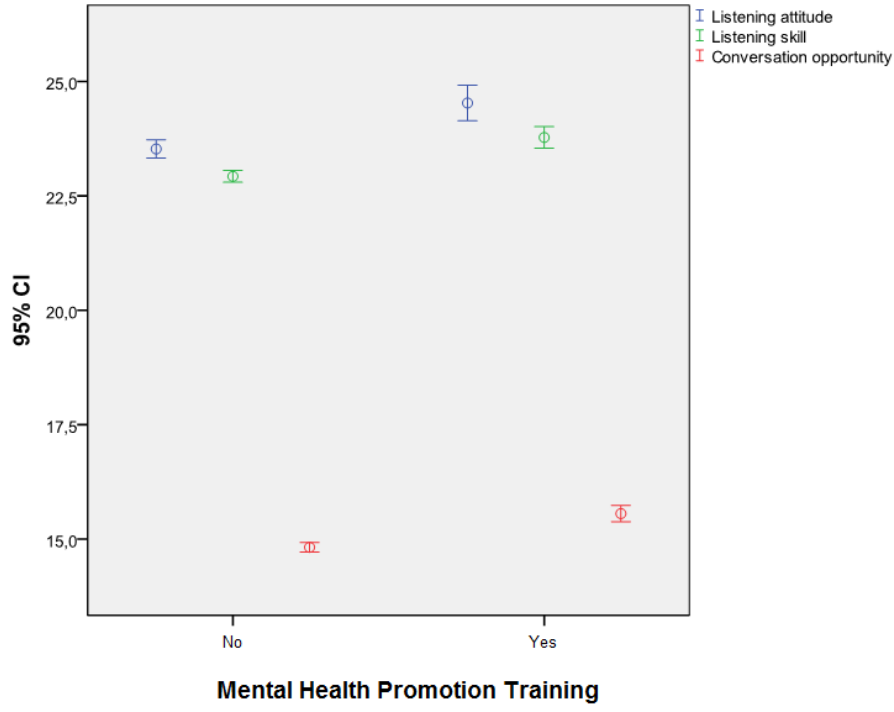
Figure 4. Error bars for ALAS subscales for those that had received mental health promotion training and for those that had not.